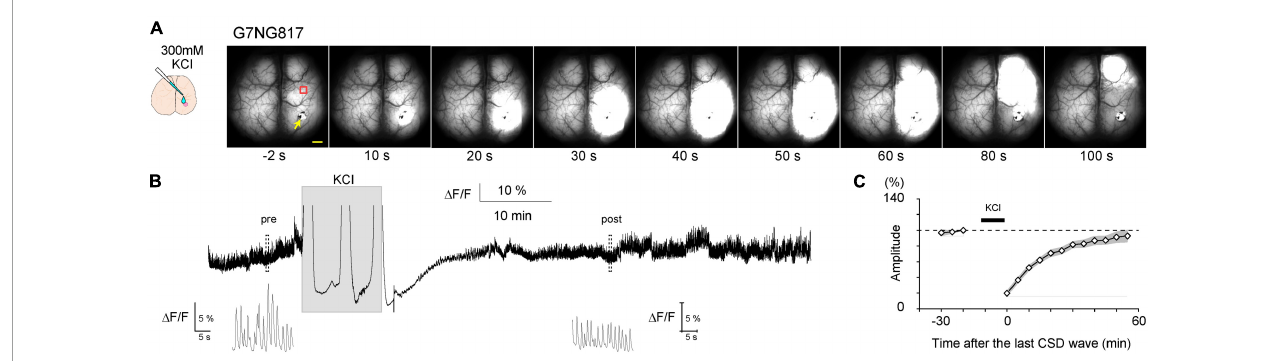
FIGURE6 Typical example of a cortical spreading depolarization (CSD)-associated Ca 2 + wave in an anesthetized G7NG817 mouse observed by transcranial cortex-wide macro imaging. (A) KCl (300 mM) was topically applied to a small craniotomy above the visual cortex at time 0. The yellow arrowhead points to the KCl application site. Representative Ca 2 + dynamics shown in (B,C) were recorded in an ROI ∼ 2 mm anterior to the KCl application site (red square). Scale bar 1 mm. (B) Example trace of Ca 2 + signal (G-CaMP7 (cid:49) F/F) from the same animal shown in (A) . Insets are magnified plots of the respective pre- and post-periods marked by dotted rectangles showing UP/DOWN state slow oscillations that occur during urethane anesthesia. [Modified from Monai et al. (2021)].